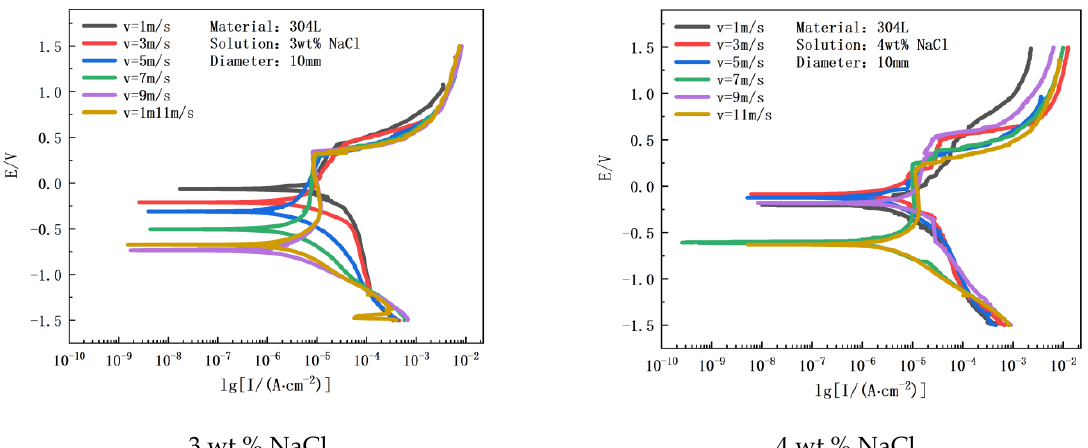
Figure 6. Polarization curves of 304L stainless steel at different flow velocities. The fitted resulting current density and potential are shown in Table 2 for the 4 wt.%